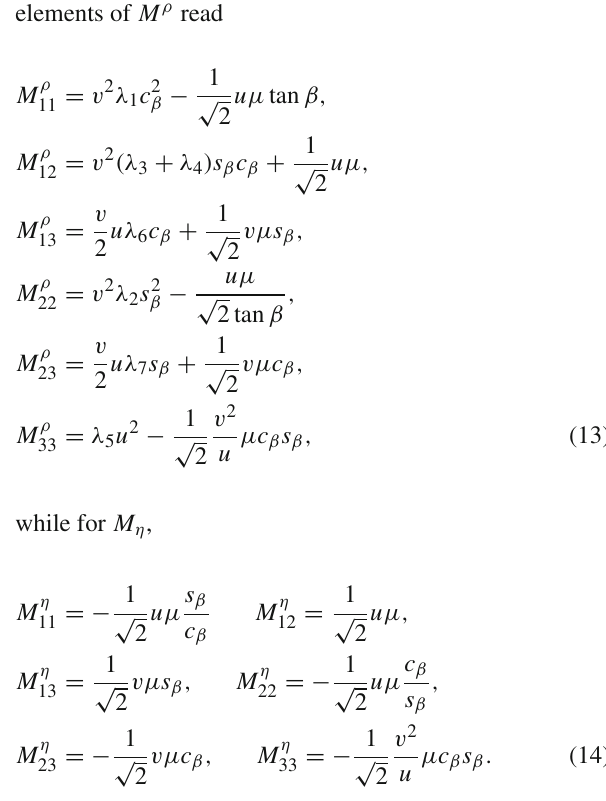
and the notation s β = sin β , c β = cos β , the independent elements of M ρ